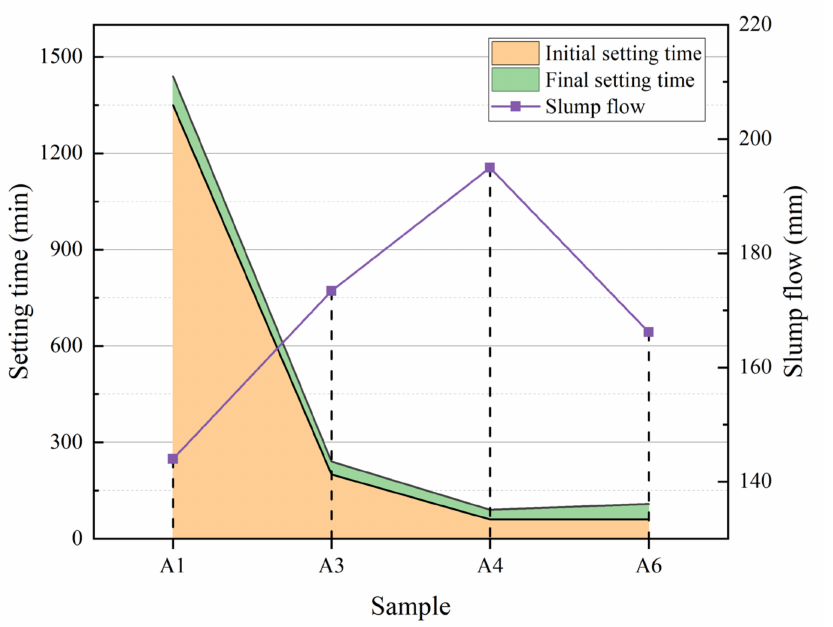
Figure 6. Working performance of UHPC based on composite cementitious